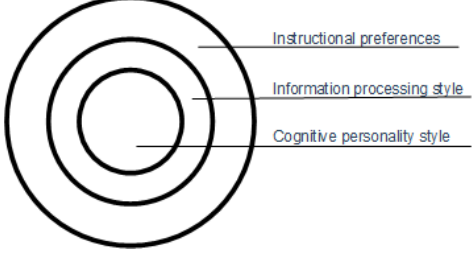
Fig. 1. Curry´s model of learning styles